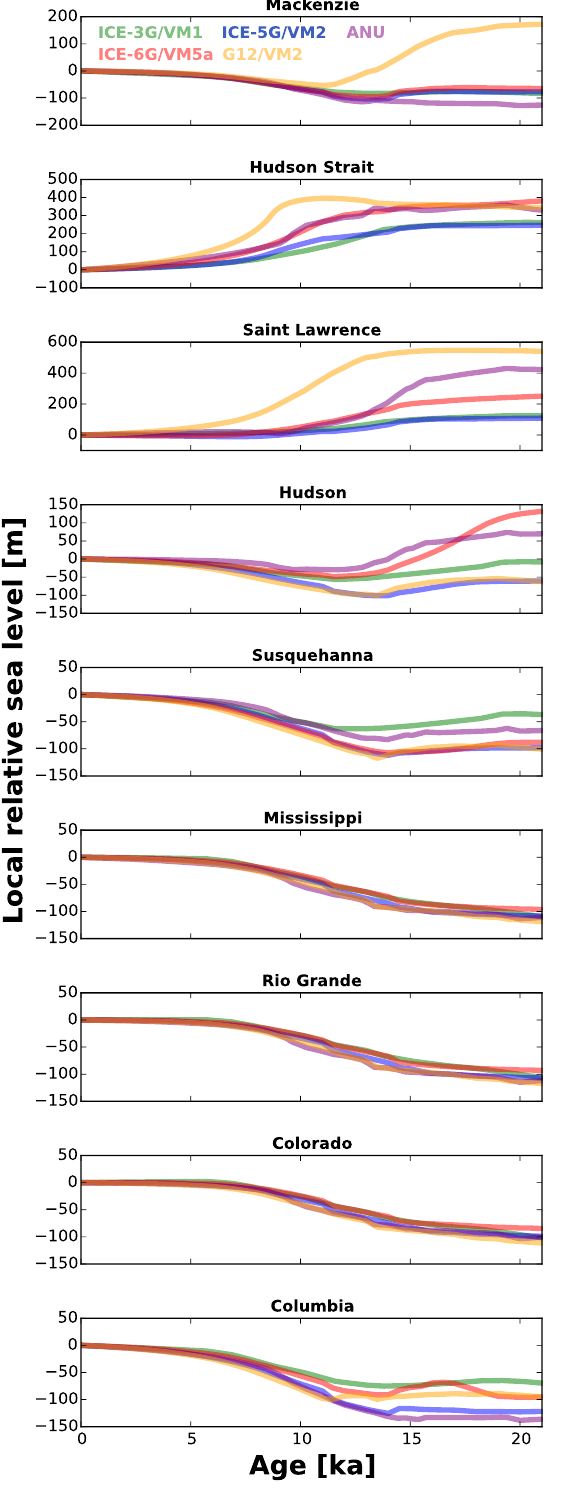
Figure 6. Modeled sea-level curves at river mouths (Fig. 5). River mouths formerly near (or under) thick ice have more variable sea- level histories, illustrating the divergent GIA histories result from different ice-sheet and solid-Earth